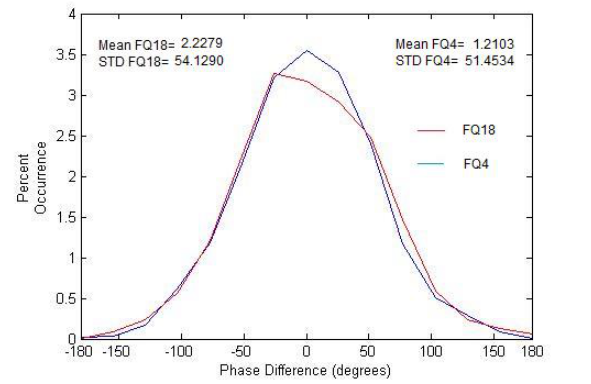
Figure 5. PPD distribution for White Spruce